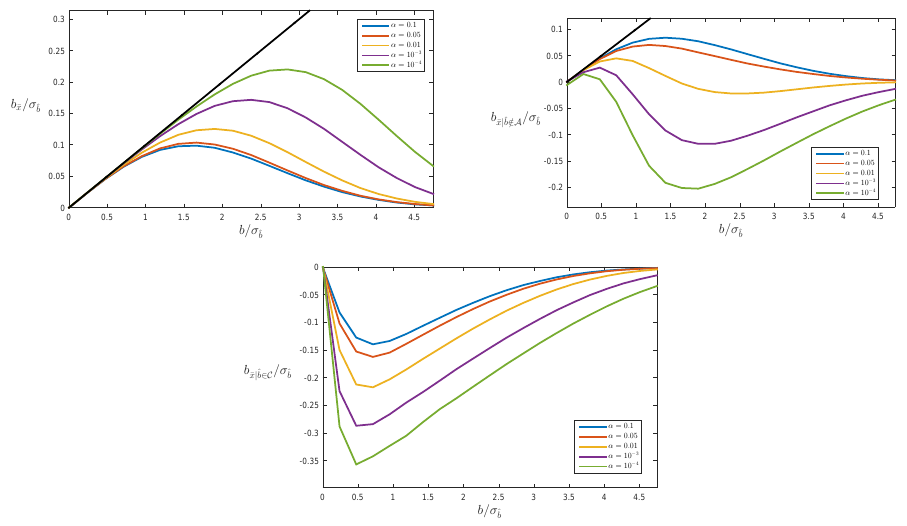
Figure 6. Three types of biases with m = 10 for model (29). (top left): unconditional bias b ¯ x = E ( ¯ x − x |H 1 ) . (top right): correct detection bias b ¯ x | CD = E ( ¯ x − x | CD, H 1 ) . (bottom): correct identification bias b ¯ x | CI = E ( ¯ x − x | CI, H 1 ) ( C is the correct identification area for ˆ b ). The black straight line corresponds with the ’no-testing’ bias b ˆ x